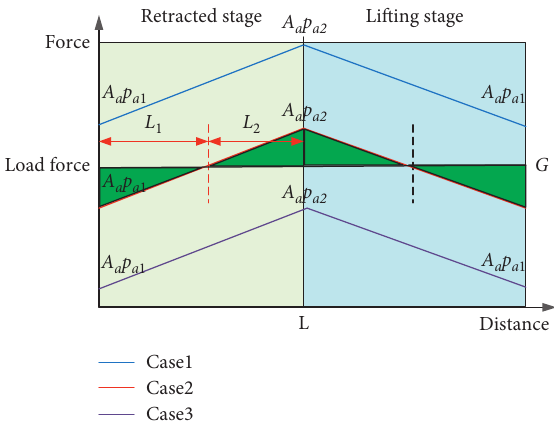
Figure 2: Comparison of different design schemes of the hydraulic